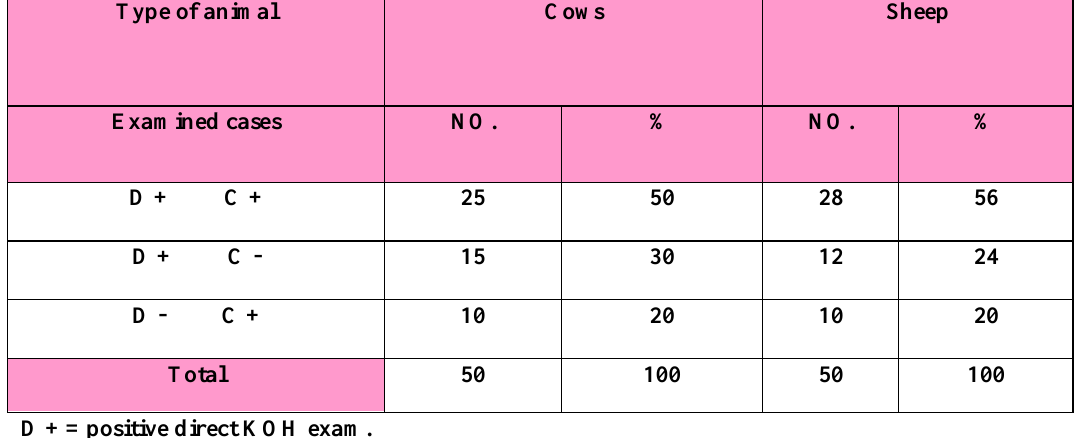
Figure (1): Incidence of dermatophytes infection in different types of animals. Table (1): Relation between direct KOH mount smear and direct culture of 50 cases of both Cows and